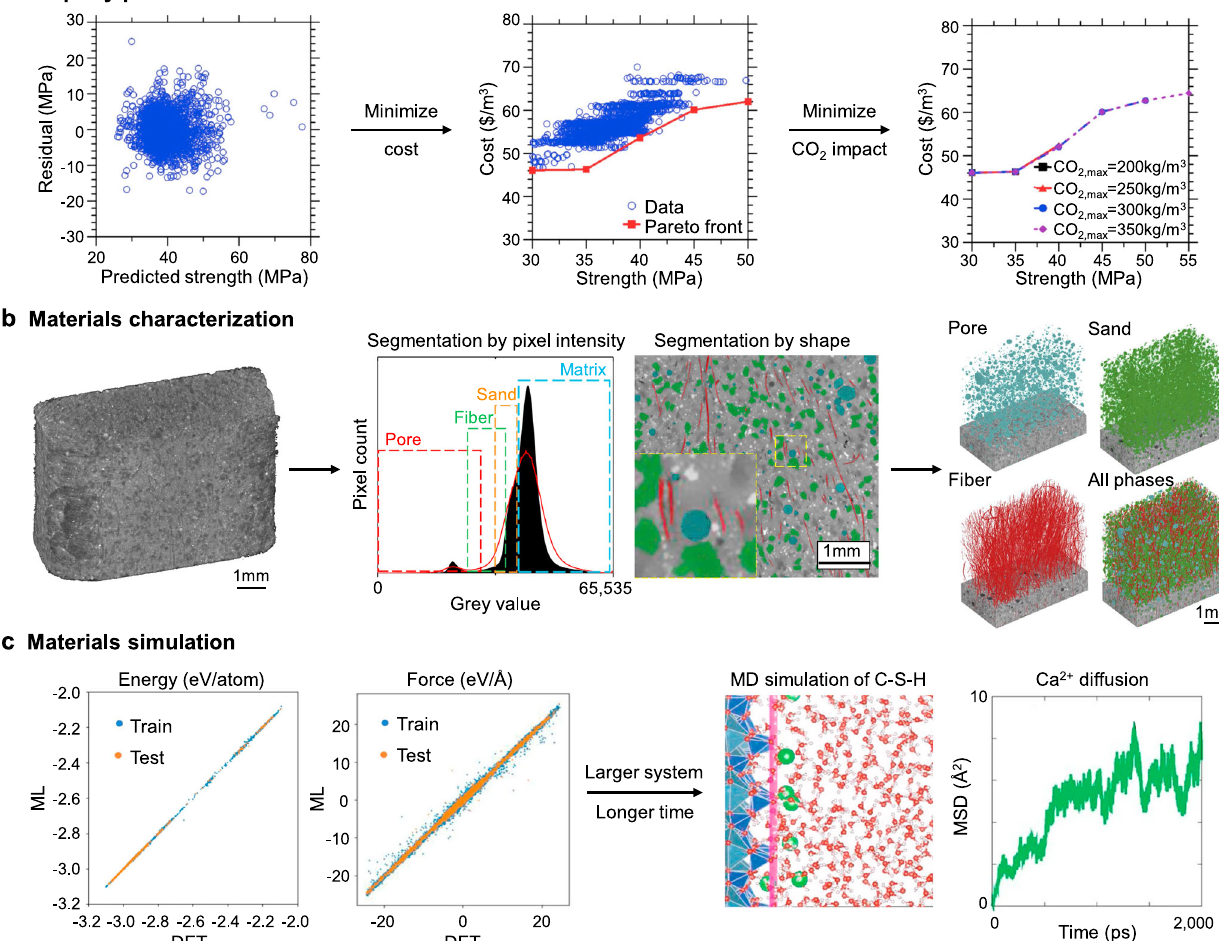
Fig. 3 Applications of machine learning (ML) in concrete science. a Concrete compressive strength prediction (left) followed by mixture design optimization, e.g., strength-cost optimization (middle) and strength-cost-CO 2 optimization (right) 54 . b Automated segmentation of X-ray computed tomography images for multi-phase cementitious composites with pores, aggregates, fi bers, and cement matrix 70 . c Large- scale molecular dynamics (MD) simulation of calcium silicate hydrate (C-S-H) using ML potential 75 . DFT, density-functional theory; MSD, mean square displacement. Figure adapted with permission from: a , ref. 54 , Elsevier; b , ref. 70 , Elsevier; and c , ref. 75 ,